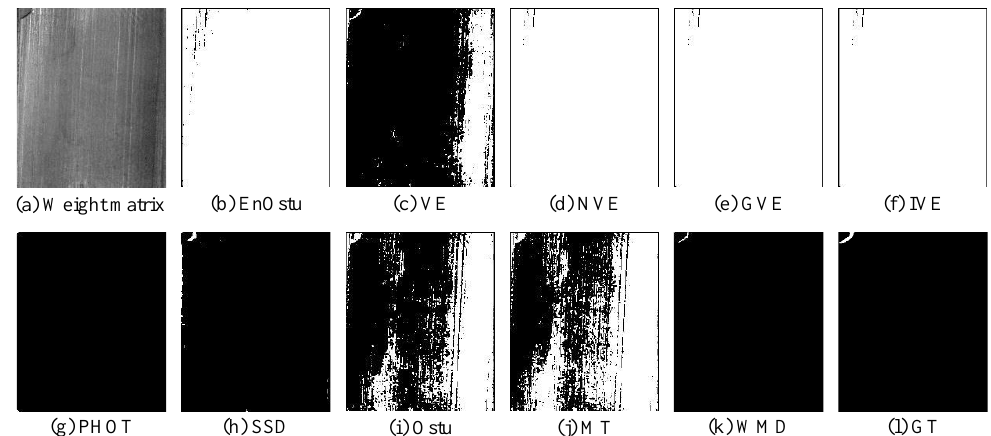
Figure 9. Visual comparisons of detection results of the ten methods on the image with multiple defects. The detection result of the proposed WMD method is quite close to ground truth, whereas the other competing methods are unable to either identify the defect location or completely separate the defect from the background.